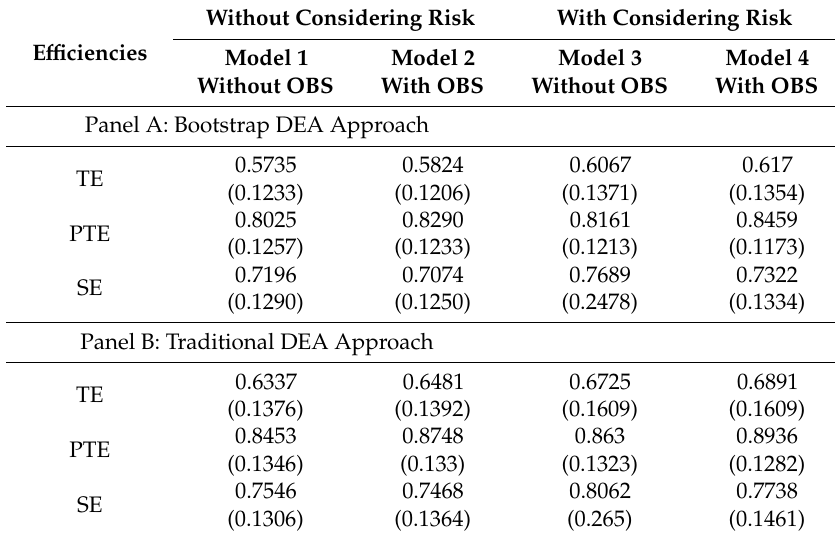
Table 4. Average technical e ffi ciency, pure technical e ffi ciency, and scale e ffi ciency of 4 e ffi ciency estimation models. 3